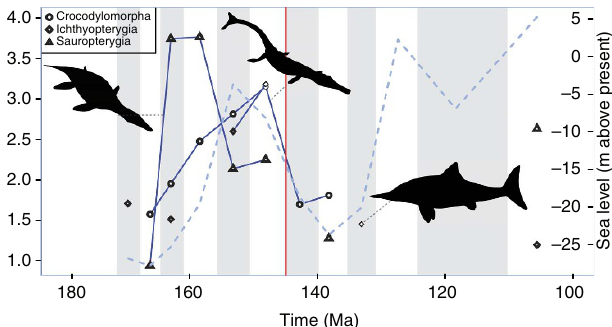
Figure 3 | Global marine SQS diversity for major Late Jurassic to Early Cretaceous pelagic clades. Sea level curve from Miller et al. 53 . Silhouettes from Phylopic courtesy of Gareth Monger and Michael Keesey (see http://phylopic.org/ for additional license